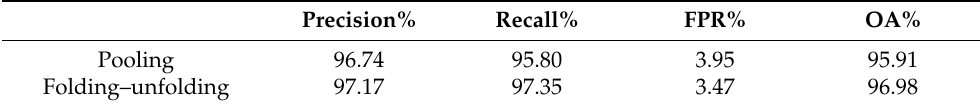
Table 3. Assessment of the detection results by folding–unfolding and pooling on the test set.